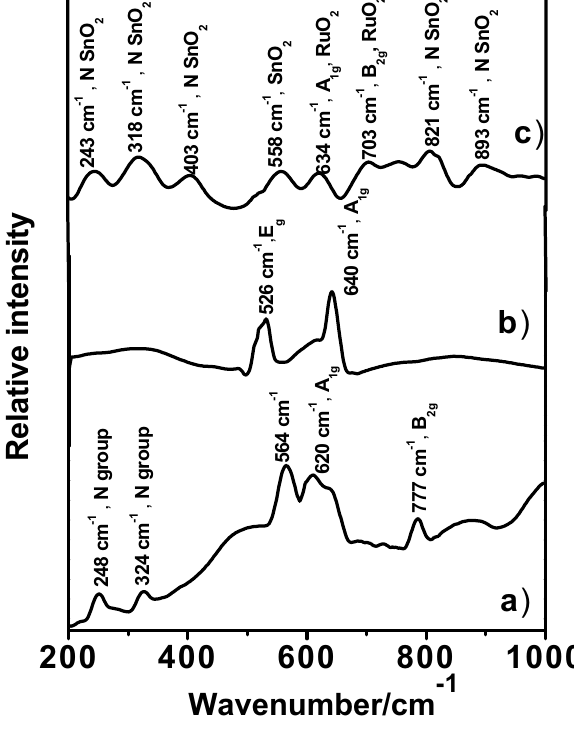
Fig. 3 FT-Raman spectra of a SnO mixed thin